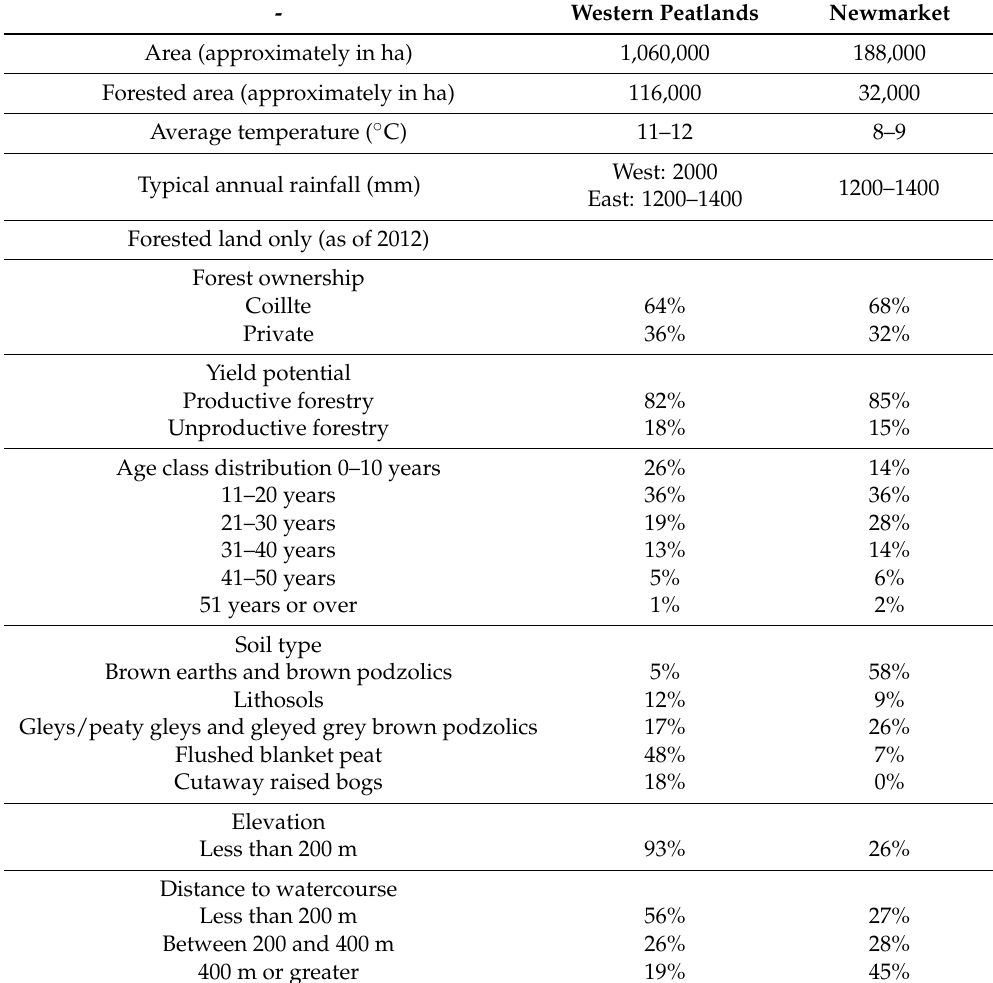
Table 1. Statistics associated with the Western Peatlands and Newmarket case study